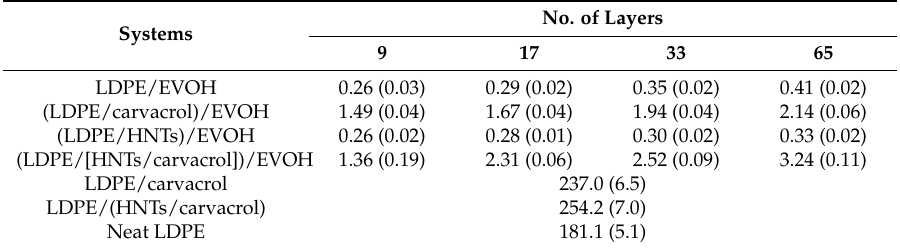
Table 4. Oxygen transmission rate (OTR)( O 2 ) [cc · mm/(m 2 · day)], of the films (the number in parenthesis indicate the standard deviation obtained from at least three independent